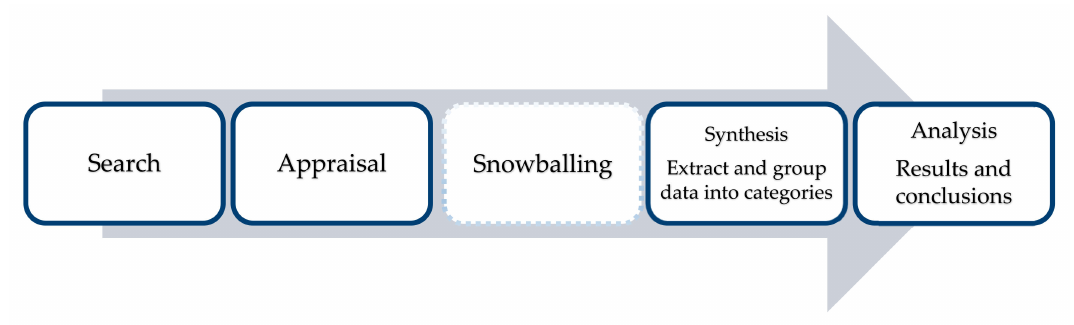
Figure 1. SALSA framework used in the research for literature